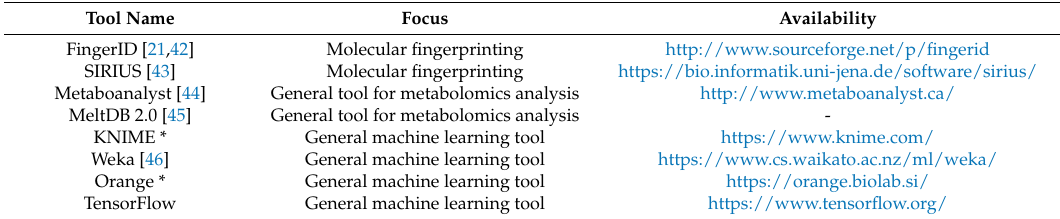
Table 2. Freely available software tools providing machine learning methods applicable to the metabolism